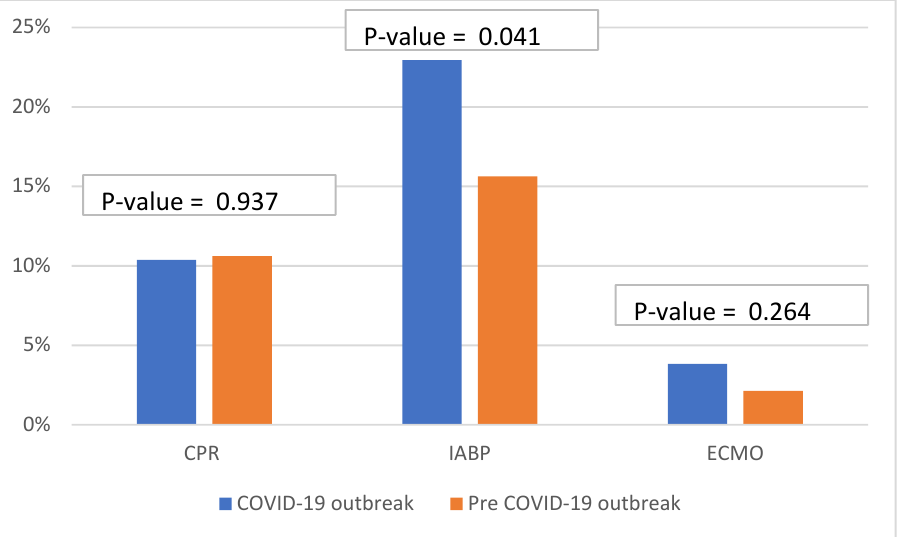
Figure 1. The bar charts show the important clinical characteristics of STEMI patients in pre-COVID- Figure 1. 19 period and during the COVID-19 outbreak.